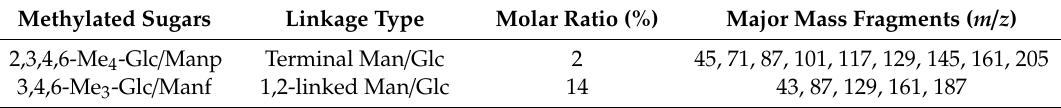
Table 1. PD1-1 methylation results.